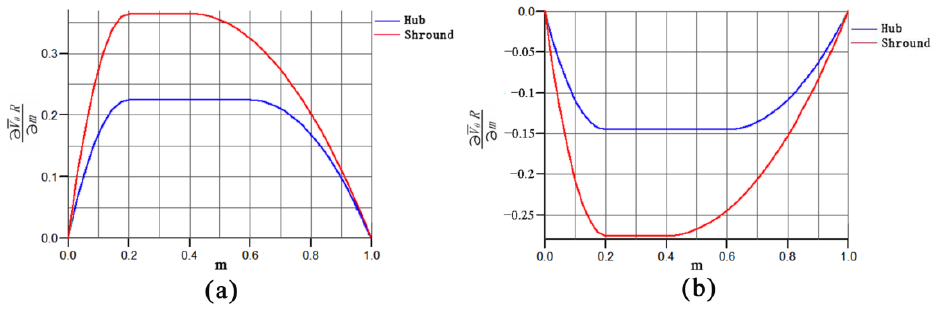
Figure 7. Load of the rotor and stator blades. ( a ) Load of the rotor, ( b ) Load of the stator blades.